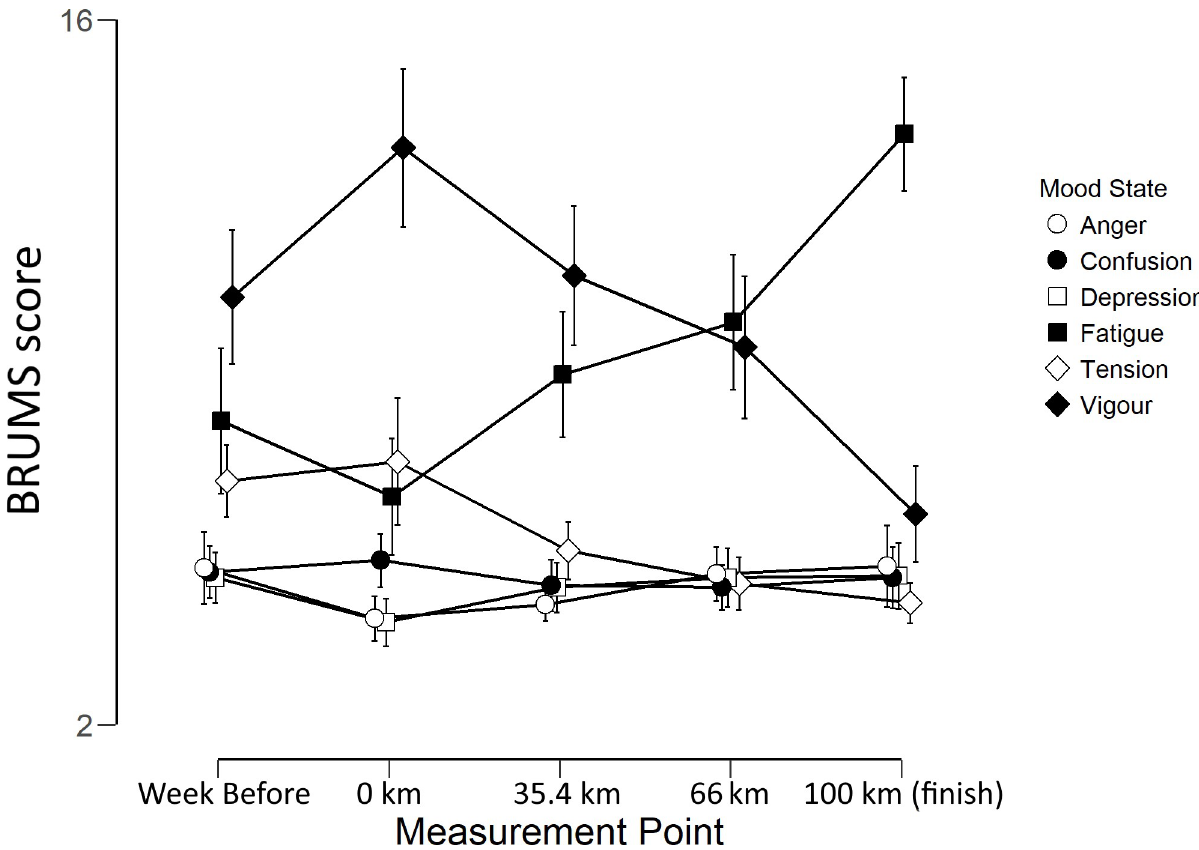
Fig 1. Mean BRUMS scores for each Mood Factor at each Measurement Point (km). Error bars show 95% confidence intervals.